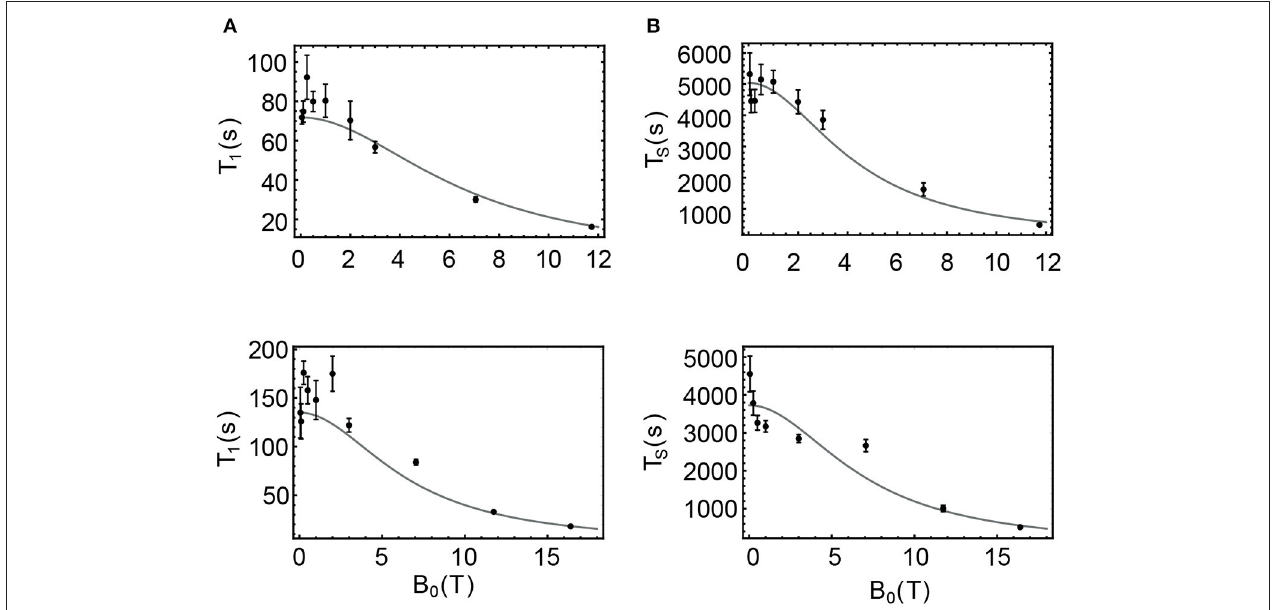
FIGURE 7 | Filled circles are the values of T 1 and T S experimentally measured for samples NapAce (A,B) and NapCo2e (C,D) , also available in Table 3 . The gray curves are the predicted values of these decay constants obtained using Equations 5–8.